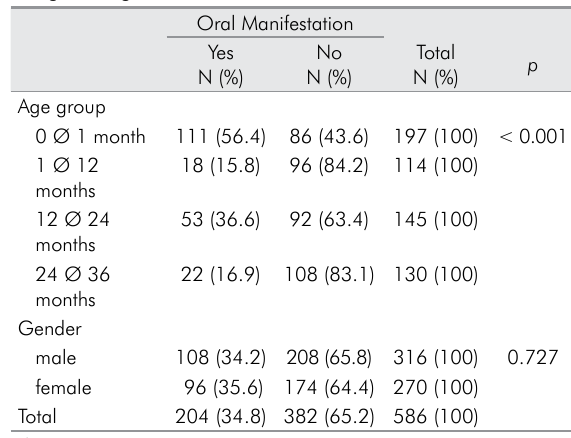
Table 1. Distribution of oral manifestation cases according to age and